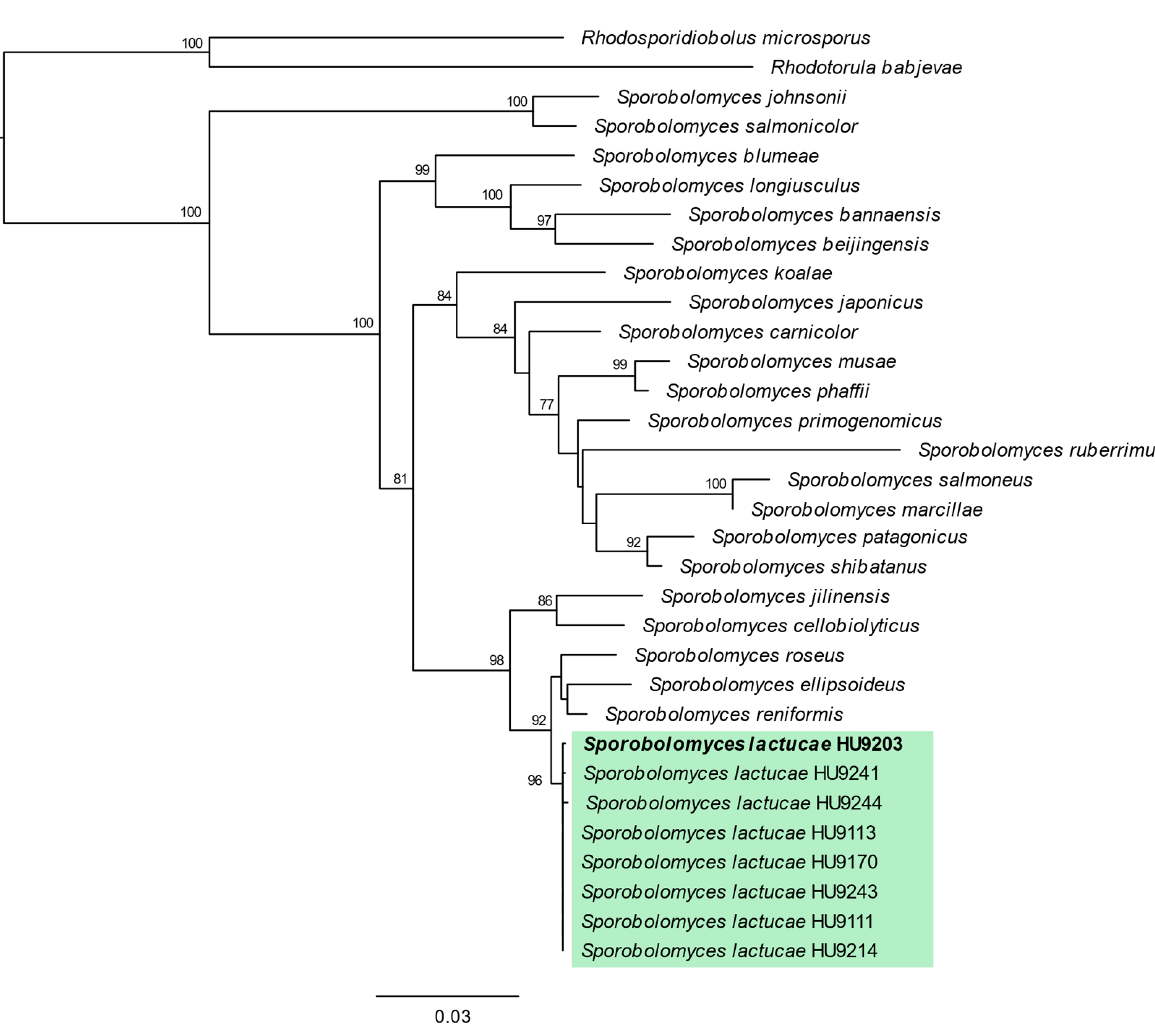
Figure 1. Phylogeny of Sporobolomyces s.s. reconstructed from a four-locus dataset. Only ex-type strains were included in this analysis, and the holotype selected for S. lactucae sp. nov. is highlighted in bold. Threshold for maximum likelihood bootstrap values was 70.